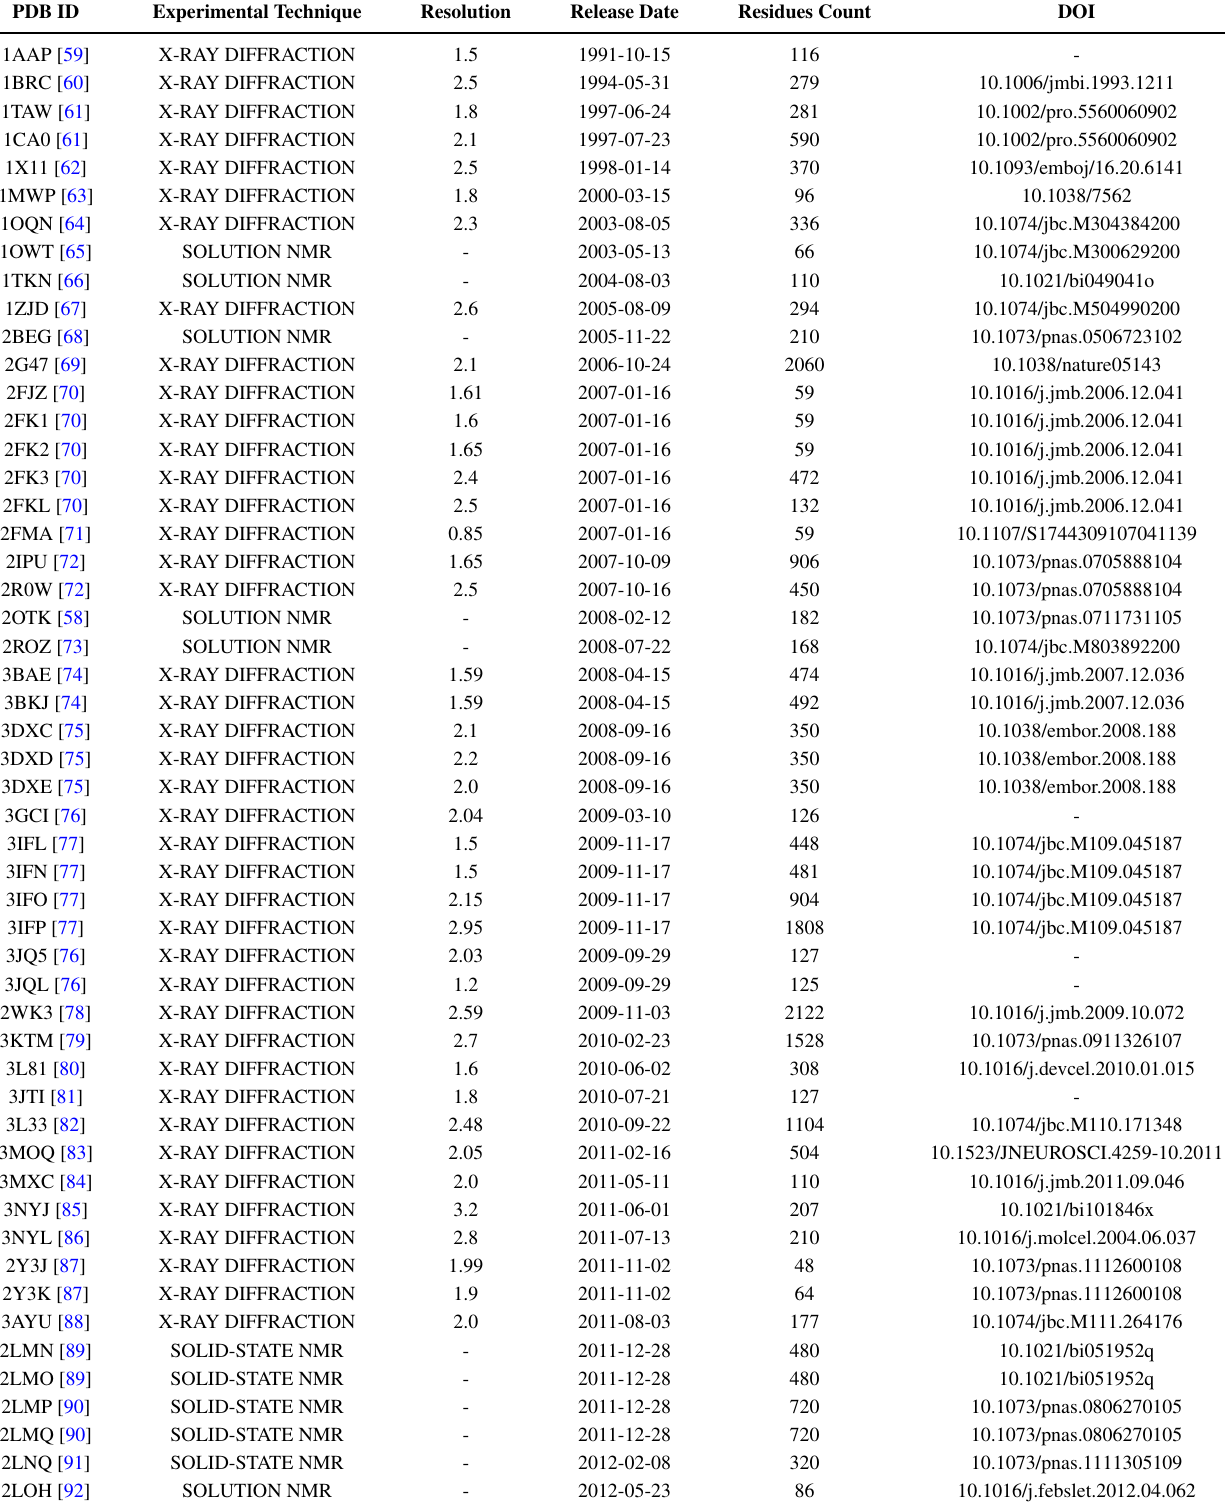
Table 2. Experimental data of amyloid beta oligomers, fibrills and binding